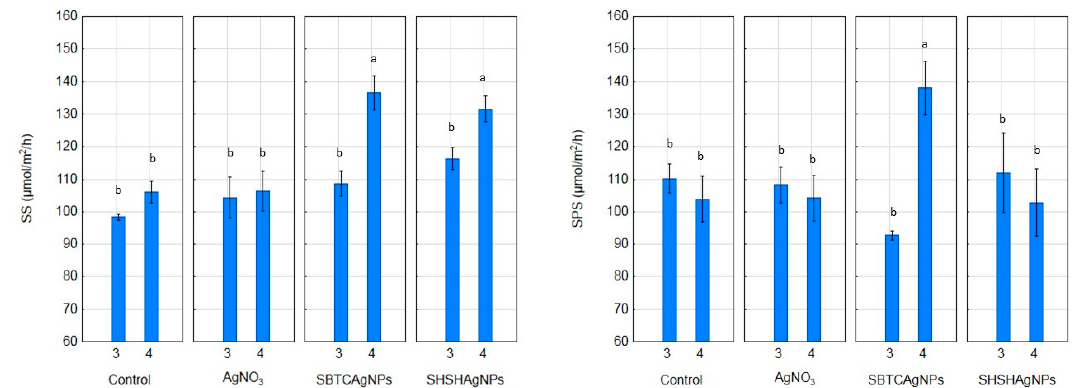
Figure 4. Sucrose Synthase (SS) and Sucrose Phosphate Synthase (SPS) activity in leaves of the control and the AgNO 3 , SBTCAgNPs and SHSHAgNPs treated wheat plants after the 3rd and 4th week of growth. The presented data are mean values based on five replicates. Mean values marked with the same letter within a treatment did not differ significantly according to Duncan’s test at p ≤ 0.05.